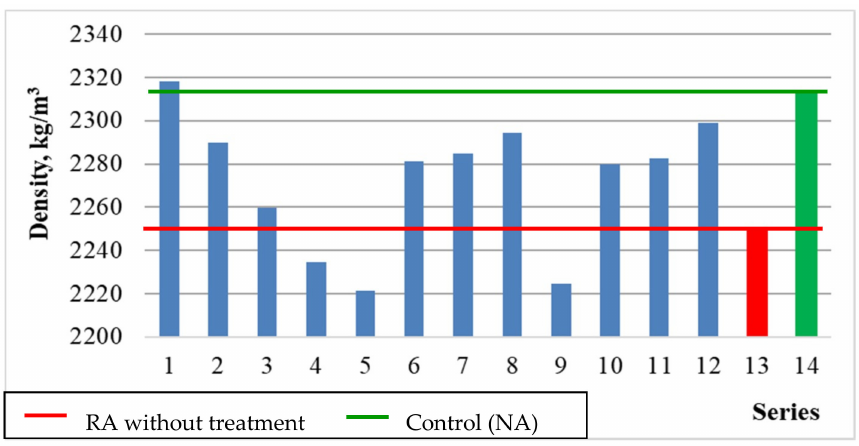
Figure 12. The volume density of concretes compared with series 13 and 14.